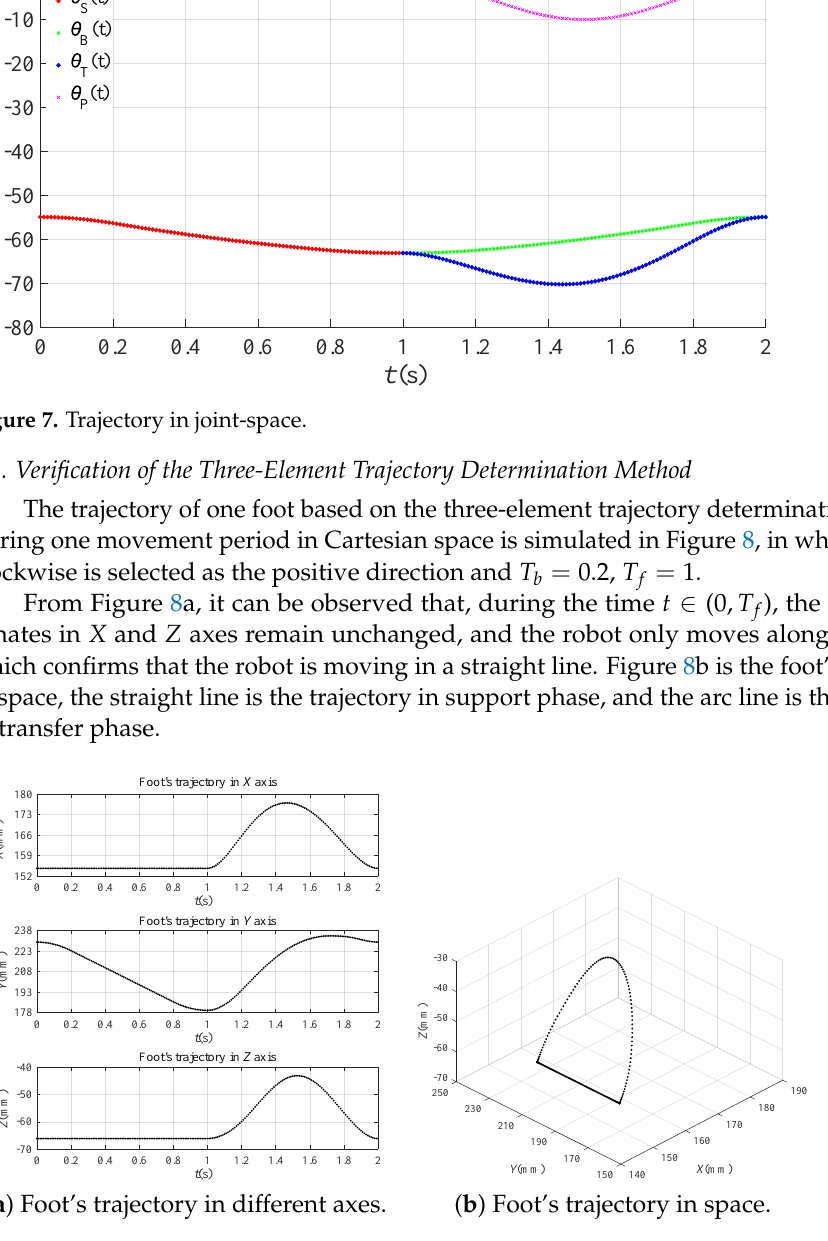
Figure 8. Trajectory in Cartesian